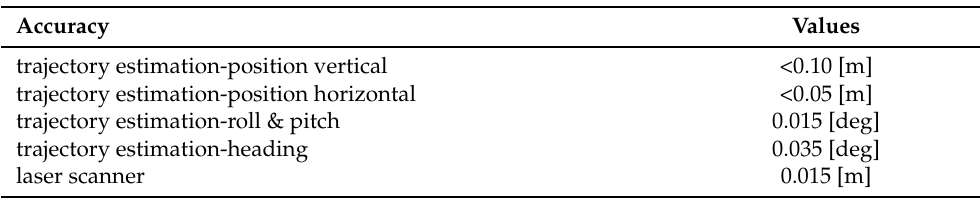
Table 2. Error budget of the UAV-based laser scanning system based on RIEGL miniVUX-SYS according to manufacturer’s specification